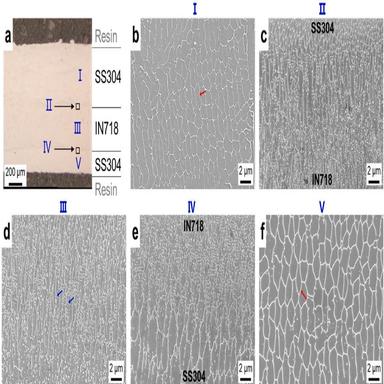
Case-4: (a) Locations of interest; Microstructures of (b) the top SS304 layers with pronounced sub-grain boundaries (red arrow), (c) the upper IN718-SS304 CGZ, (d) the middle IN718 layers with a large number of Laves phase (blue arrows), (e) the lower SS304-IN718 CGZ, and (f) the bottom SS304 layers with sub-grain boundaries (red arrow). (For interpretation of the references to colour in this figure legend, the reader is referred to the Web version of this article.)